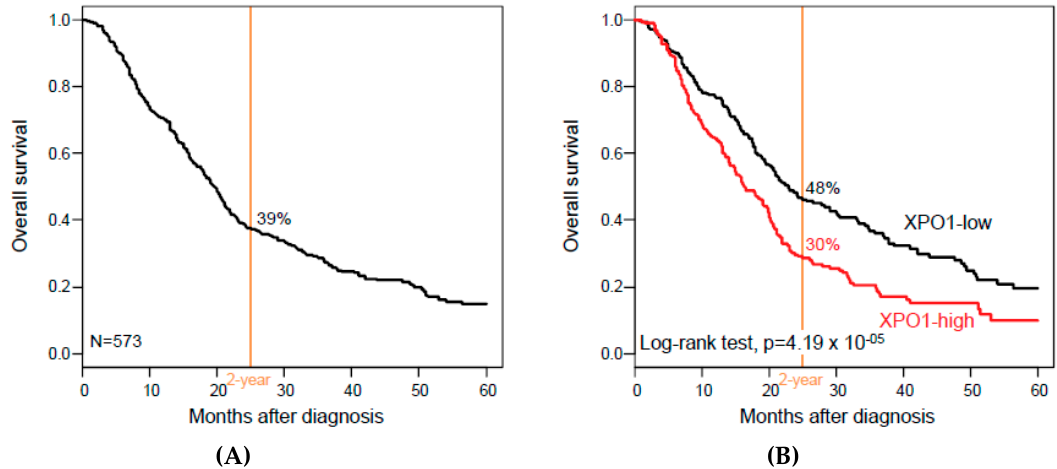
Figure 2. Overall survival (OS) in patients with PAC according to XPO1 expression. ( A ) Kaplan–Meier metastasis-free survival (MFS) curves in all patients with PAC. ( B ) Similar to A, but according to the XPO1-based classification (“XPO1-high” and “XPO1-low” classes). In univariate analysis (Table 2), the other variables that were associated with OS (Wald test) were the AJCC stage ( p = 3.98 × 10 − 3 ), the pathological lymph node involvement ( p = 3.80 × 10 − 5 ), the stroma classification ( p = 4.33 × 10 − 4 ), and the Bailey’s classification ( p = 1.26 × 10 − 6 ). Patients’ age and sex, and pathological tumor size and grade were not significantly associated with OS. In multivariate analysis, XPO1 expression remained significant when confronted with the significant clinicopathological variables (HR for death equal to 1.6 (95% CI, 1.23–2.09) in the “XPO1-high” class when compared with the “XPO1-low” class ( p = 5.07 × 10 − 4 , Wald test) and when confronted with the molecular subtypes (HR for death equal to 1.49 (95% CI, 1.18–1.87) in the “XPO1-high” class when compared with the “XPO1-low” class ( p = 6.68 × 10 − 4 , Wald test), suggesting an independent prognostic value. Due to the correlation between the four different molecular subtype classifications, we repeated the multivariate analyses by including XPO1 expression and each of the four classifications separately. As shown in Supplementary Table S2, XPO1 expression and each molecular classification remained significant. Of note, the same independent prognostic value was observed for XPO1 expression when analyzed in continuous value (respective p-values that are equal to 4.10 × 10 − 4 and 1.13 × 10 − 4 ).